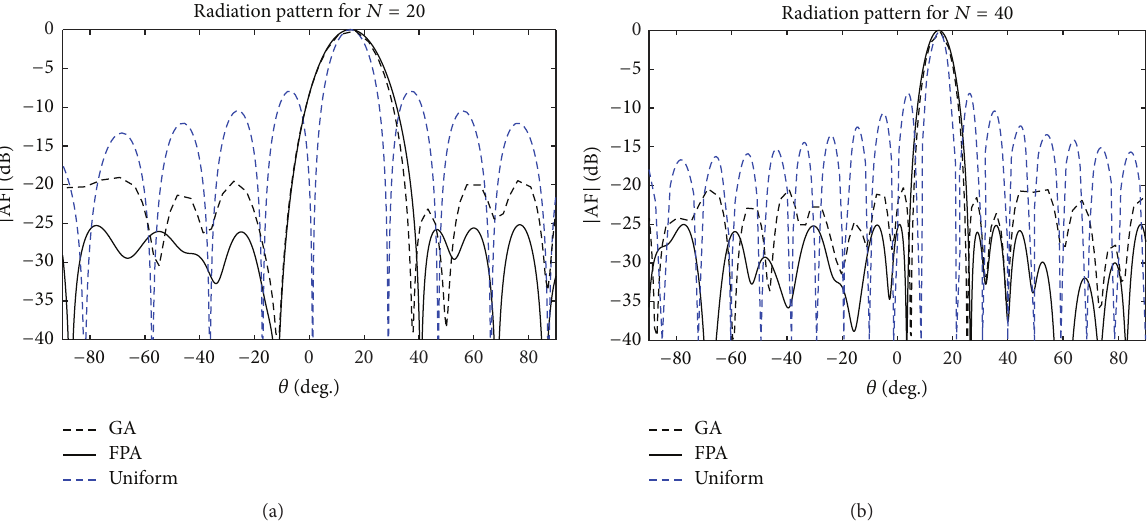
Figure 4: Comparison of the radiation patterns of CAA with main beam scanned to 15 ∘ using weights obtained by FPA and uniform distribution for (a) 𝑁 = 20 and (b) 𝑁 = 40